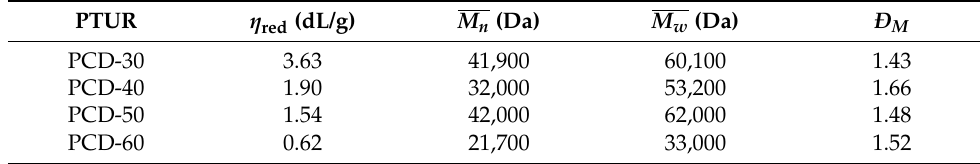
Table 3. η red values and GPC data of the PTURs.